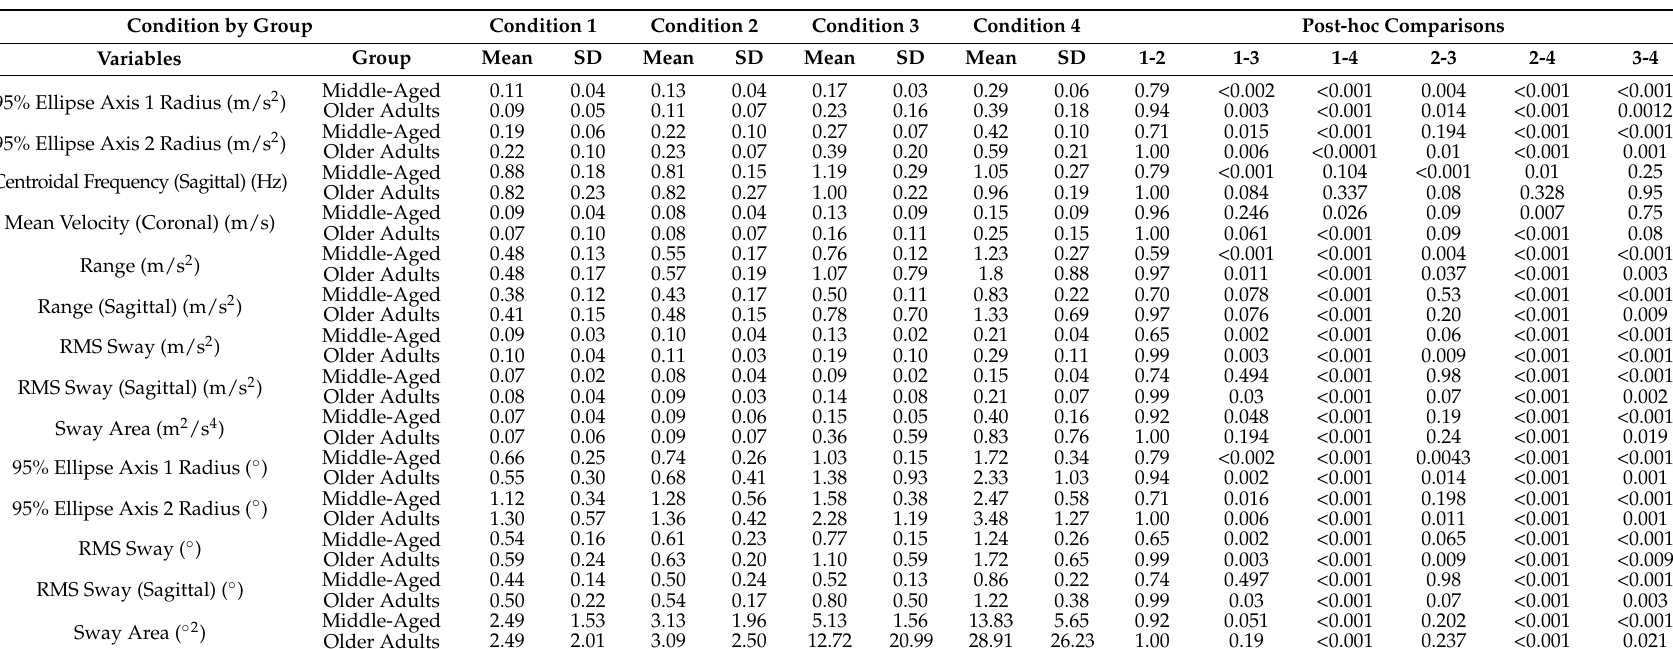
Table A5. Condition by Group post-hoc for balance variables demonstrating a significant interaction between Middle-aged Adults and Older Adults. Means and SD are presented as well as post-hoc analysis p -values for each variable and condition comparison. Condition 1: Eyes open, Firm Surface; Condition 2: Eyes Closed, Firm Surface; Condition 3: Eyes Open, Compliant Surface; Condition 4: Eyes Closed, Compliant